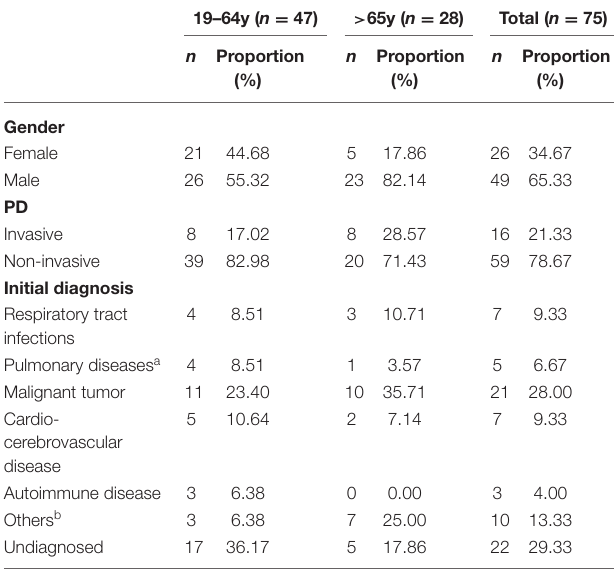
TABLE 2 | Clinical information of adult patient with PD in